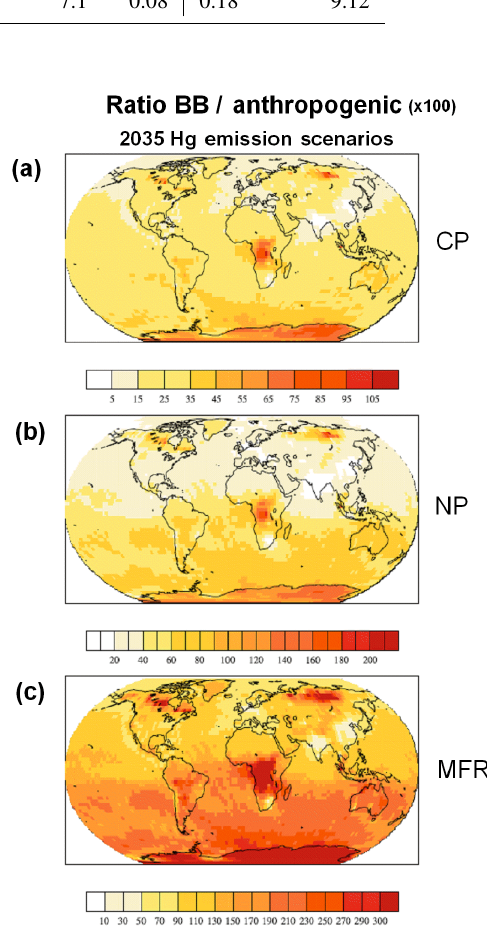
Figure 14. Ratio of the Hg deposition due to biomass burning with respect to Hg deposition due to anthropogenic emissions for three anthropogenic emissions scenarios for 2035: (a) current pol- icy (CP), (b) new policy (NP) and (c) maximum feasible reduction